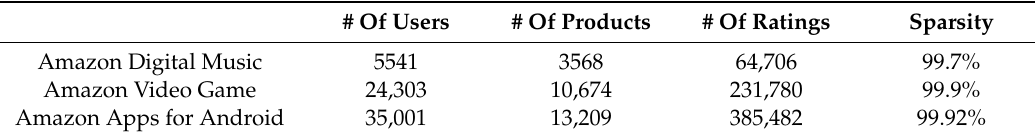
Table 3. Characteristics of the datasets used for experiments.